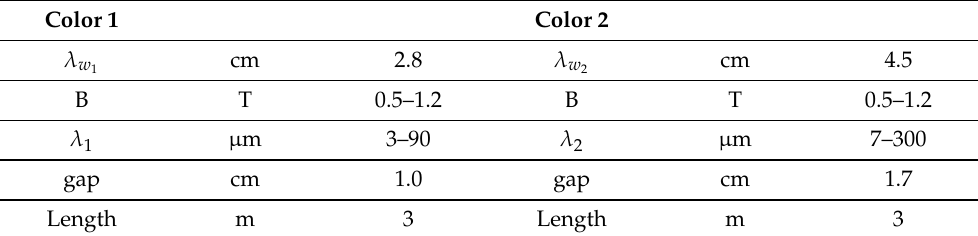
Figure 4. Radiation wavelength λ vs electron Lorentz factor γ for λ w = 2.8 cm in blue, and 4.5 cm in red. B = 1.2 T and 0.5 T. Table 2. Two color set-up: undulator